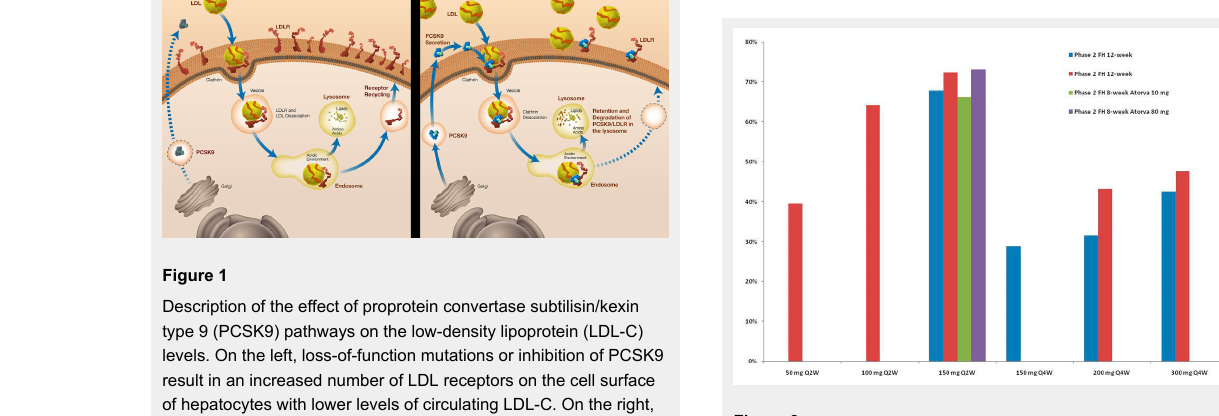
Mean percent decrease from baseline in low-density lipoprotein (LDL) cholesterol levels with the SAR236553/REGN727 regimen. Results were derived from